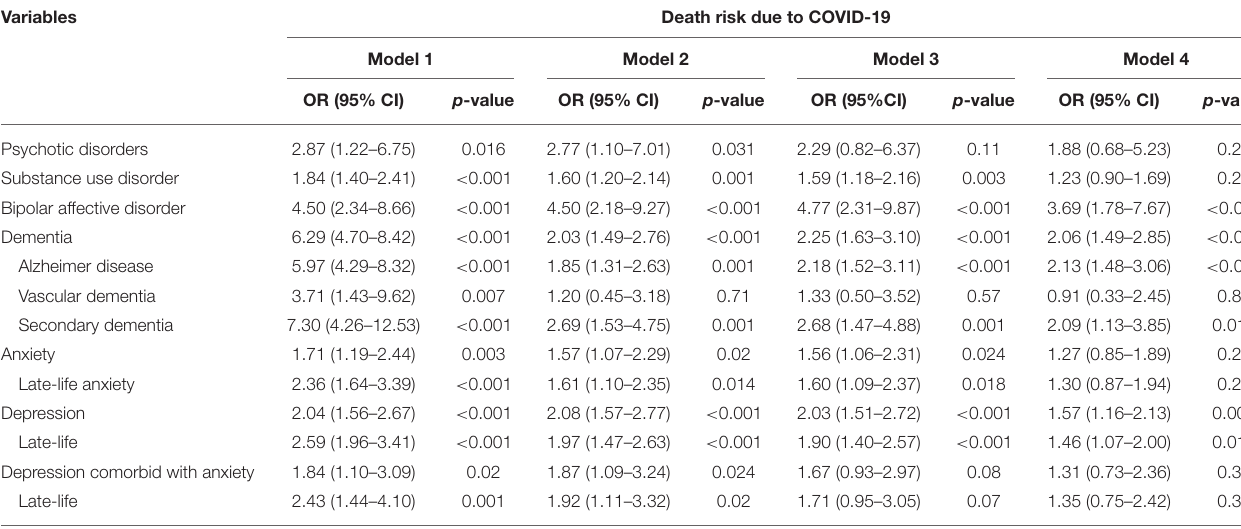
TABLE 3 | Logistic regression analysis of the association between mental disorders and risk of death due to